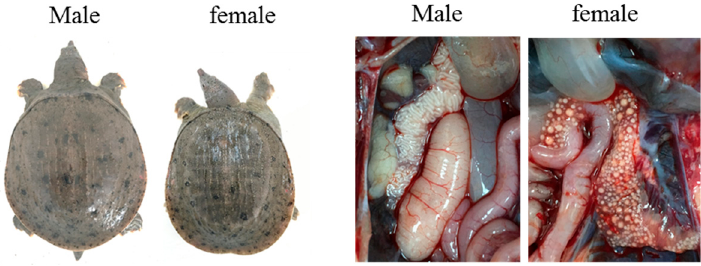
Figure 6. Morphology and gonad tissue observation in male and female Pelodiscus sinensis .